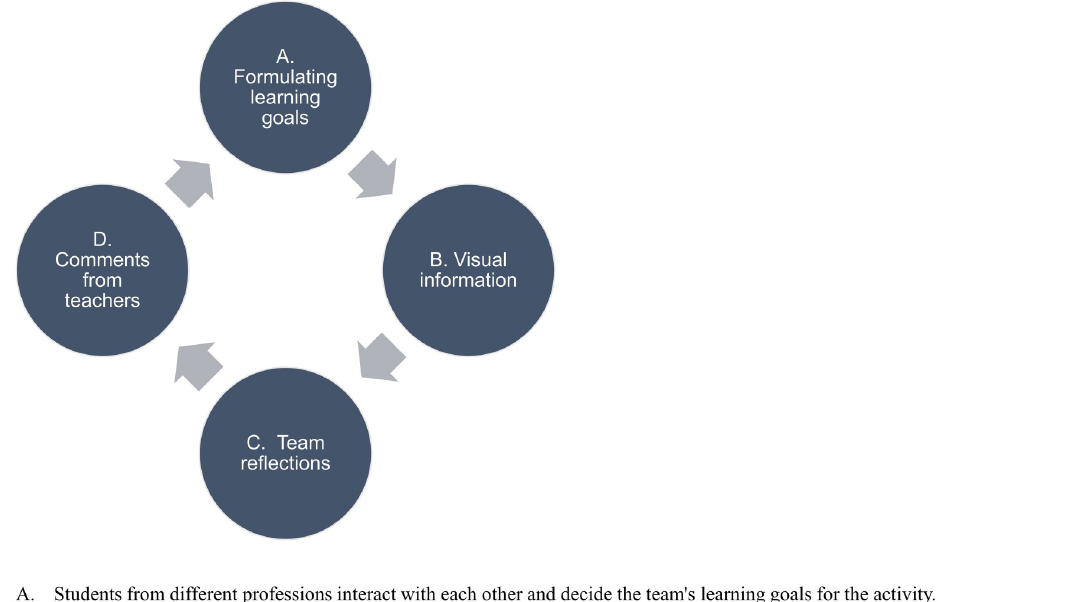
Fig 1. Interprofessional virtual patient learning